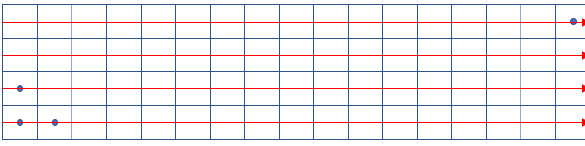
Figure 3. The illustration of grid division and the